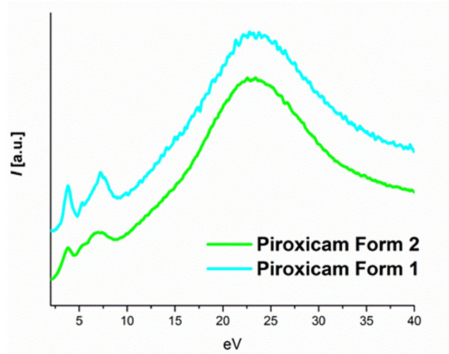
Figure 3. High resolution low loss EELS spectra from piroxicam form 1 (monoclinic crystal structure) and form 2 (triclinic crystal